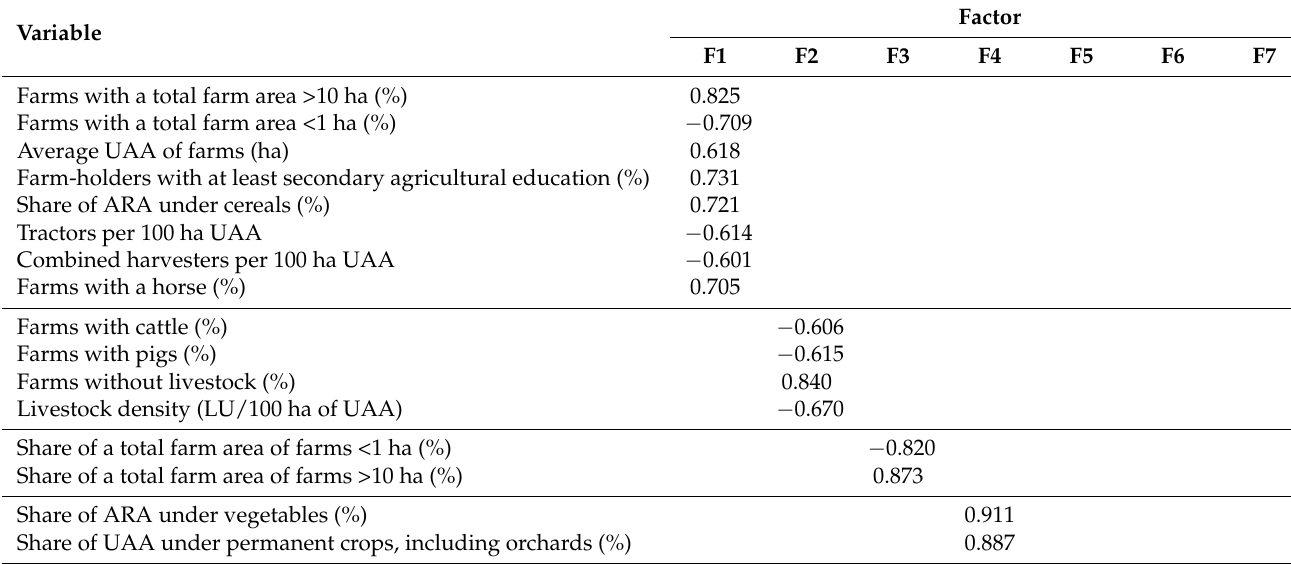
Table 3. Factor loadings of indicators of changes in farming systems (loadings